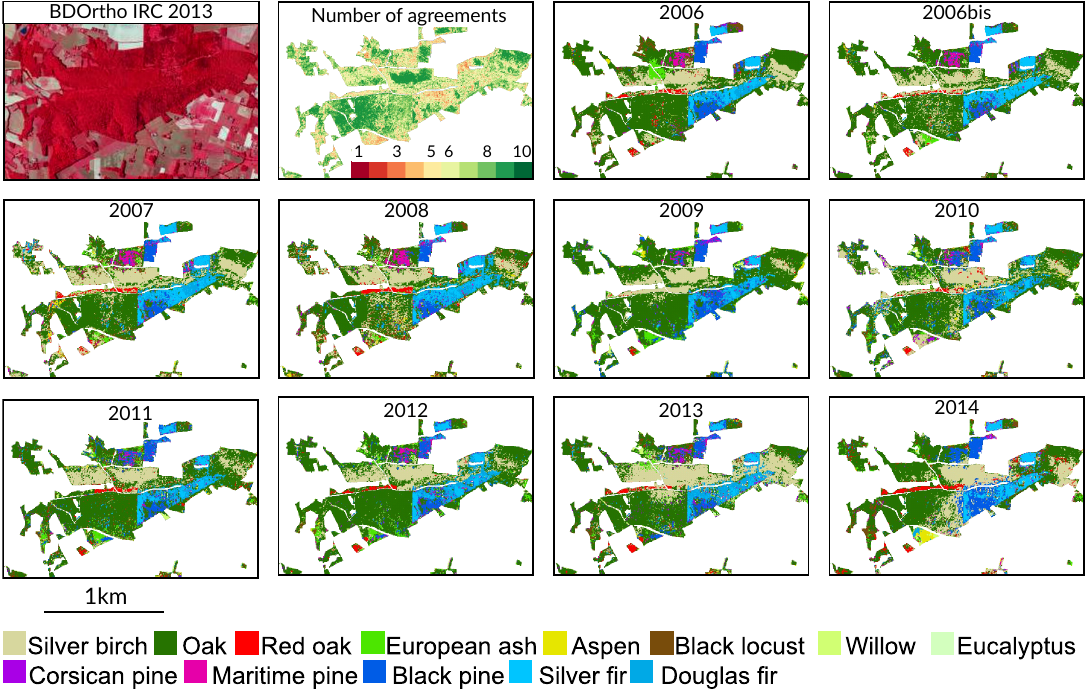
Figure 10. Annual classifications of tree species in a mixed forest composed of different conifers and broadleaf species. Instability was observed in the conifer plantations composed of Black pine, Silver fir and Douglas fir. This was also the case for Silver birch. Part of the forest (in the north) has was excluded from the analysis because of changes during the study period (clear-cuts and